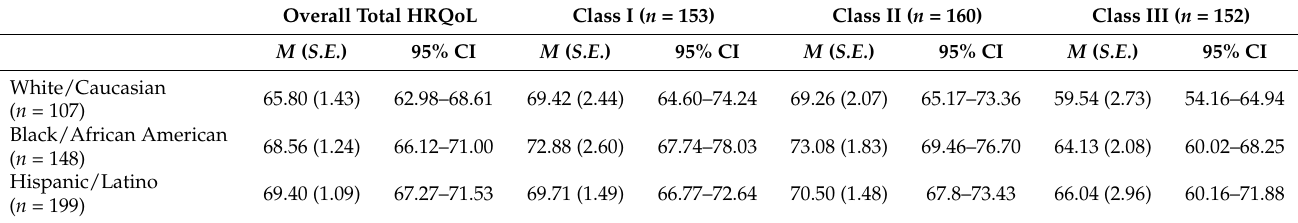
Table 4. Total HRQoL Differences across Ethnicity Groups and Obesity